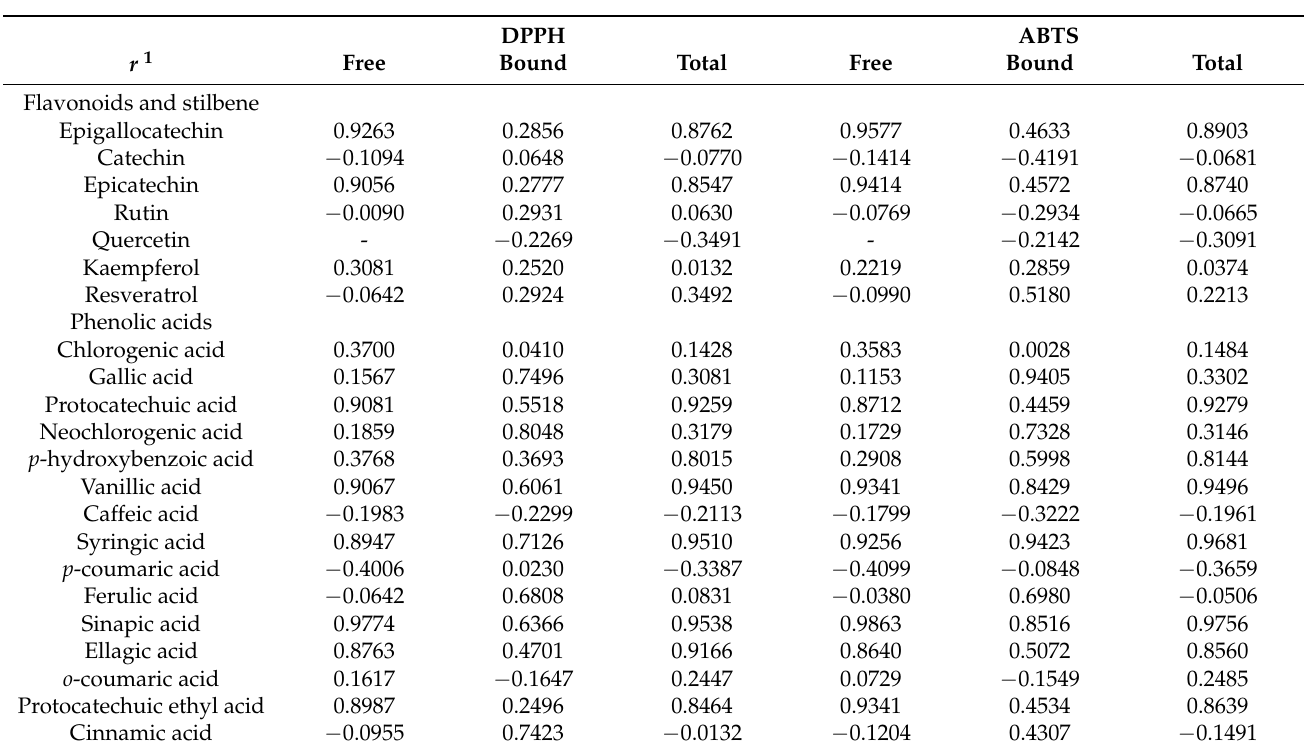
Table 7. Correlation coefficients between radical scavenging activities and some phenolic compound contents detected in the